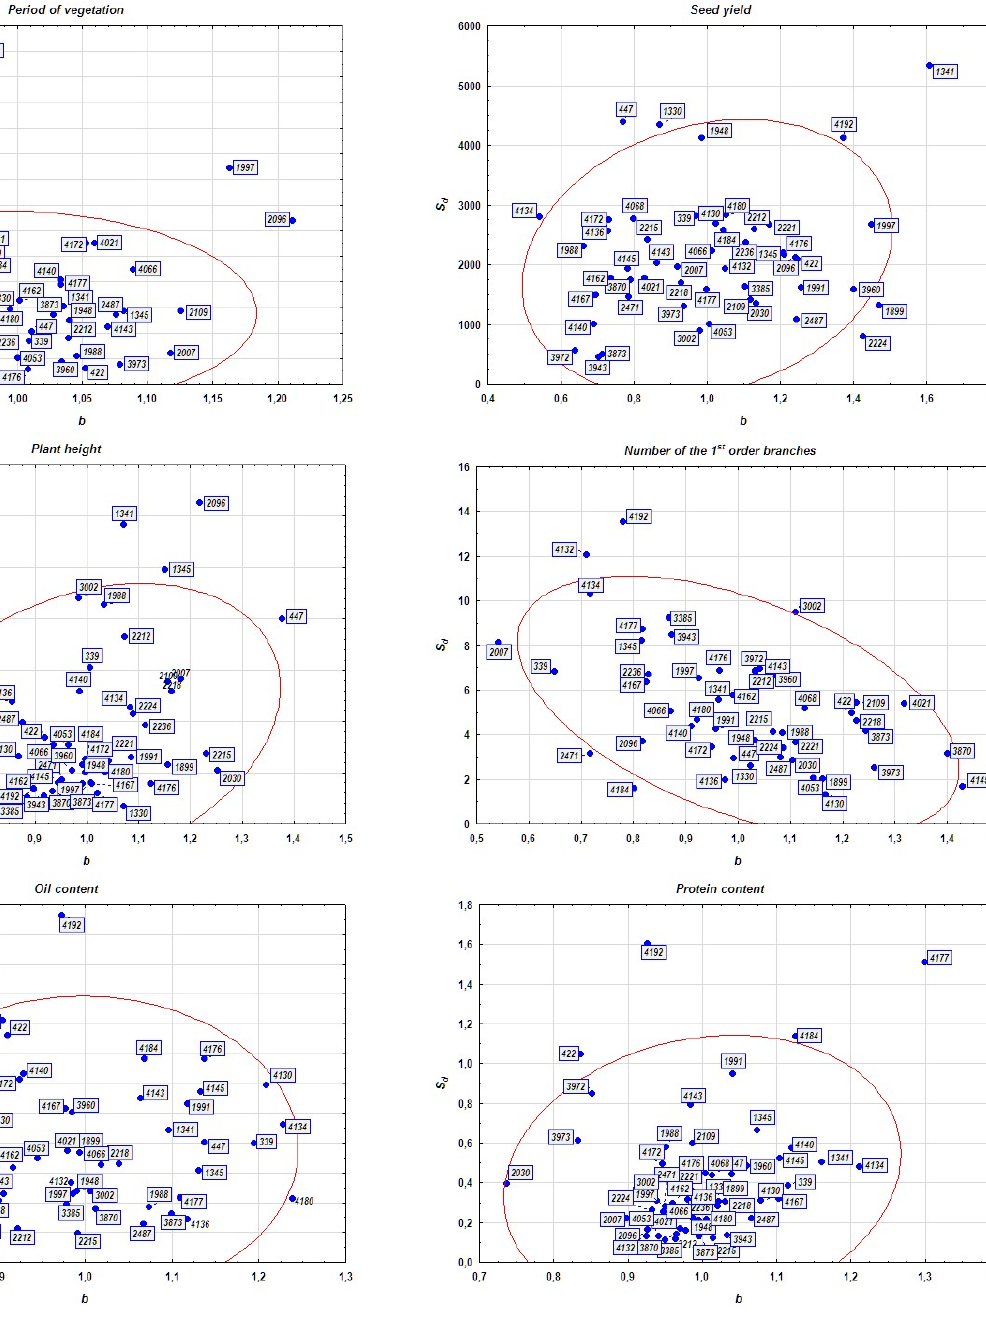
Figure 3. Distribution of the studied accessions by the parameters of stability ( b ) and plasticity ( S d ).